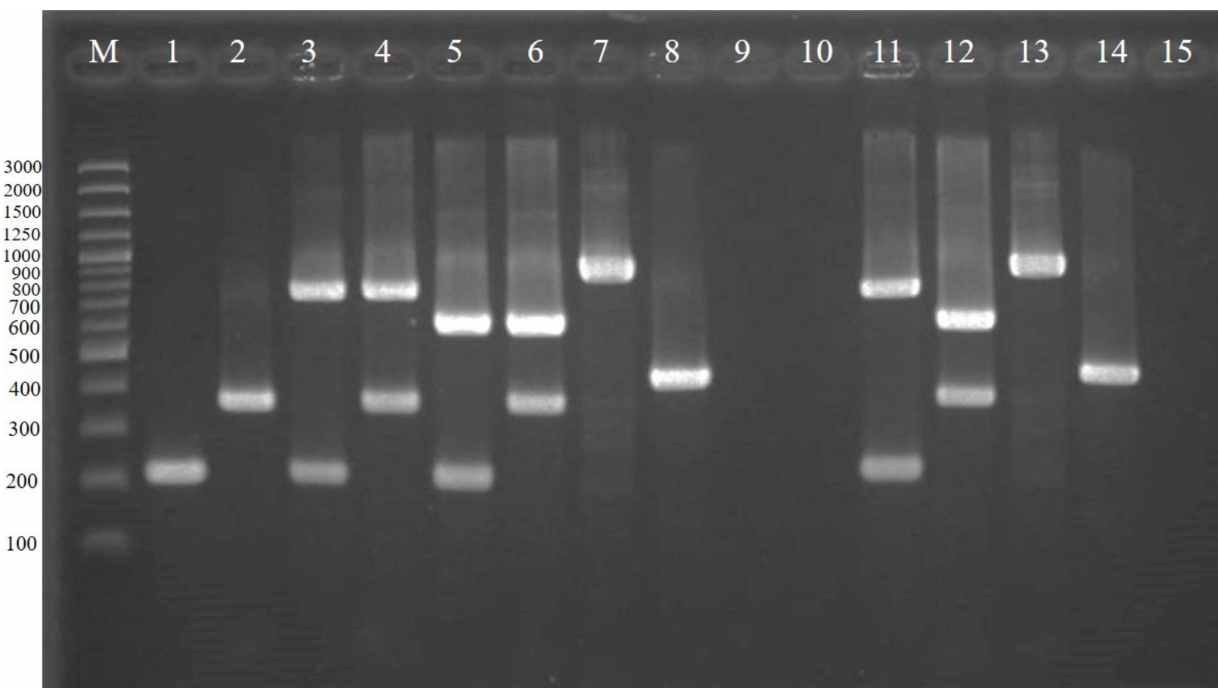
Figure 1. Agarose gel electrophoresis of PCR-amplified products from local enterococci (lane 1–10) and reference enterococci (lane 11–14). E. faecium (lane 1), E. faecalis (lane 2), E. faecium carrying vanA (lane 3), E. faecalis carrying vanA (lane 4), E. faecium carrying vanB (lane 5), E. faecalis carrying vanB (lane 6), E. gallinarum carrying vanC1 (lane 7), E. casseliflavus carrying vanC2/C3 (lane 8),